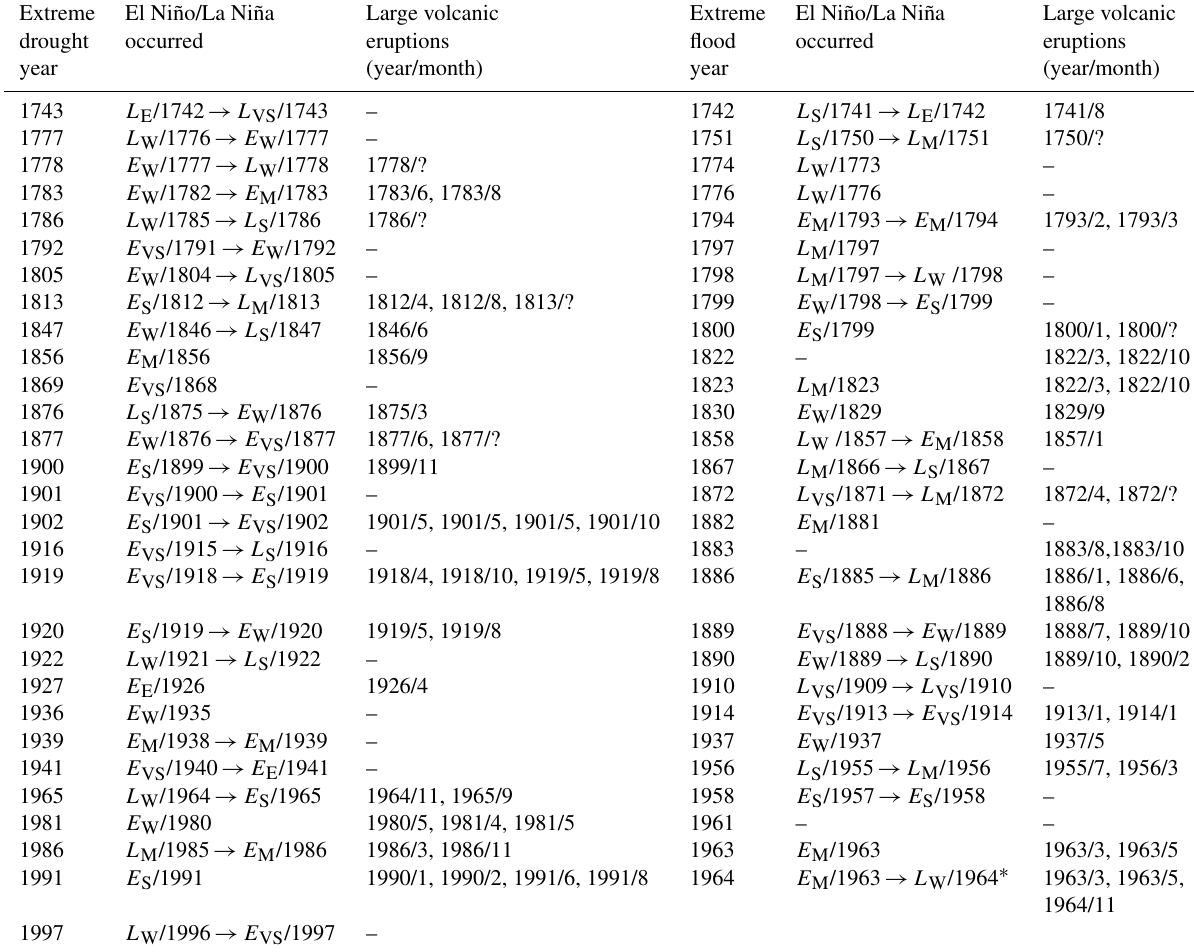
Table 1. The occurrences of El Niño and La Niña events and large volcanic eruptions in the extreme drought/flood year and its previous year. Extreme El Niño/La